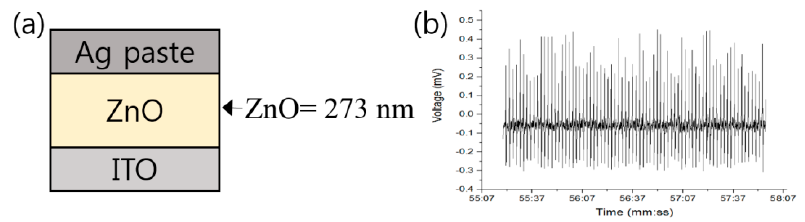
Figure 4. ( a ) Schematic diagram of control MG with a single ZnO layer used as a reference sample; and ( b ) its output voltage variation (V P ‐ P = ~0.7 mV) (ZnO film thickness = 273 nm).